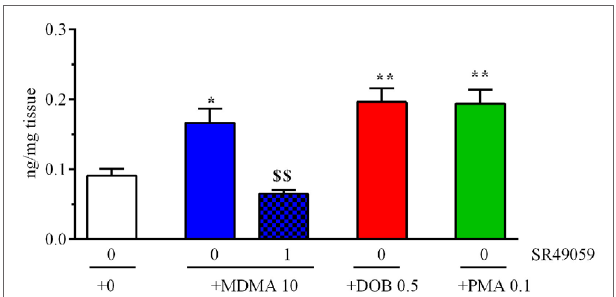
FigUre 7 | 3,4-Methylenedioxymethamphetamine (MDMA), 2,5-dimethoxy- 4-bromo-amphetamine hydrobromide (DOB), or para -methoxyamphetamine (PMA) significantly increased cerebral IT levels 5 min after treatment. Mean values ± SEM of three to four samples per group. The combination of SR49059 (1 ng/kg) and MDMA (mg/kg) significantly reduced IT levels. * p < 0.05, ** p < 0.01 vs. the corresponding saline group (0 + 0); $$ p < 0.01 vs. MDMA alone (Tukey’s